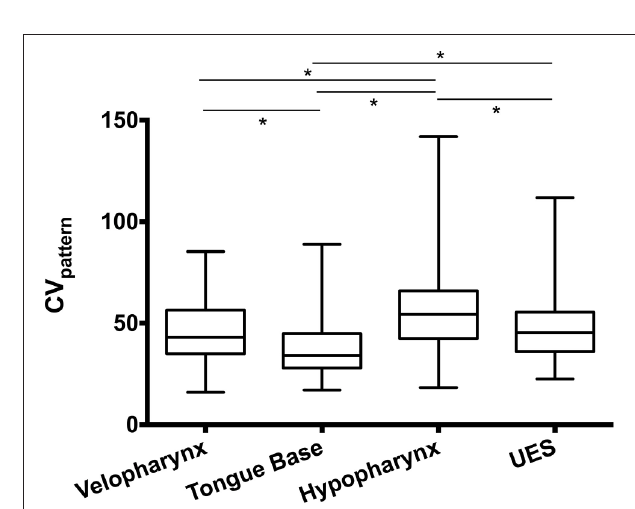
FIGURE 6 | Impacts of swallowing pressure alignment on total coefficient of variability (CV) values. UES, upper esophageal sphincter; error bars indicate standard error of the mean.